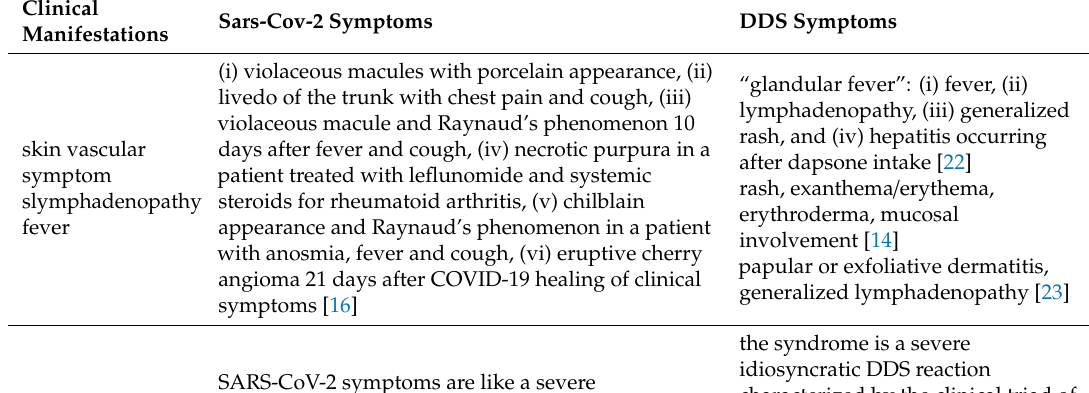
Table 1. The clinical manifestations of SARS-CoV-2 and DDS in